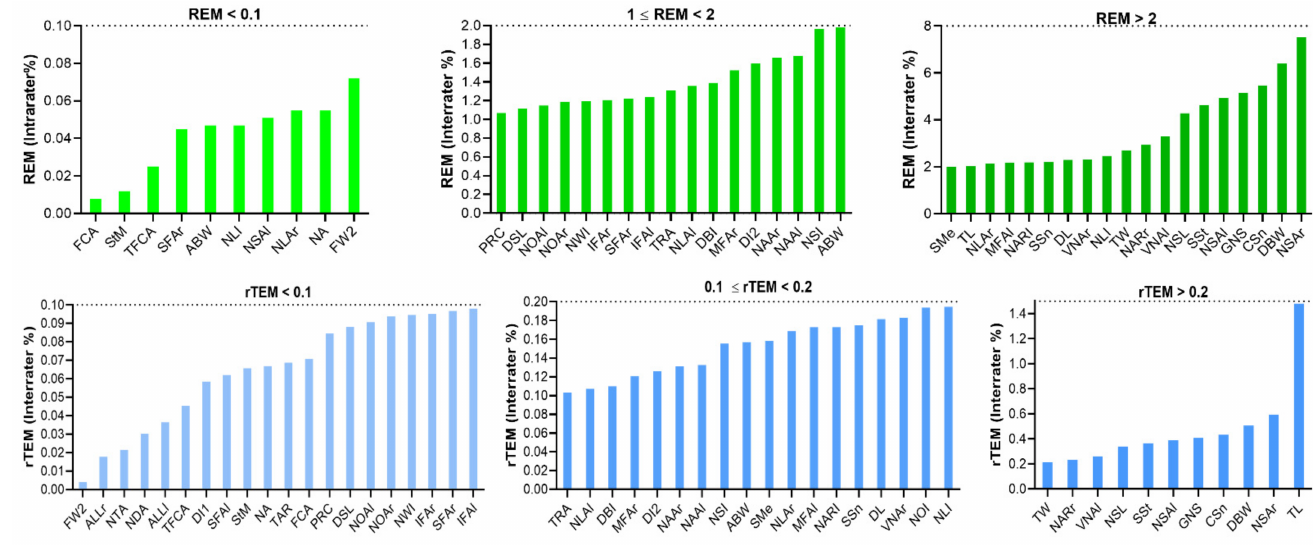
Figure 8. Inter-assessor relative error measurement (REM) and relative technical error of measurement (rTEM) of novel nasal measurements on three-dimensional images.